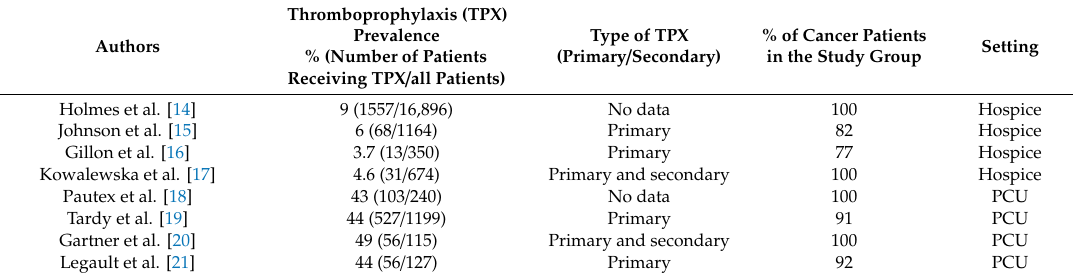
Table 1. Thromboprophylaxis (TPX) prevalence in hospice and palliative care units